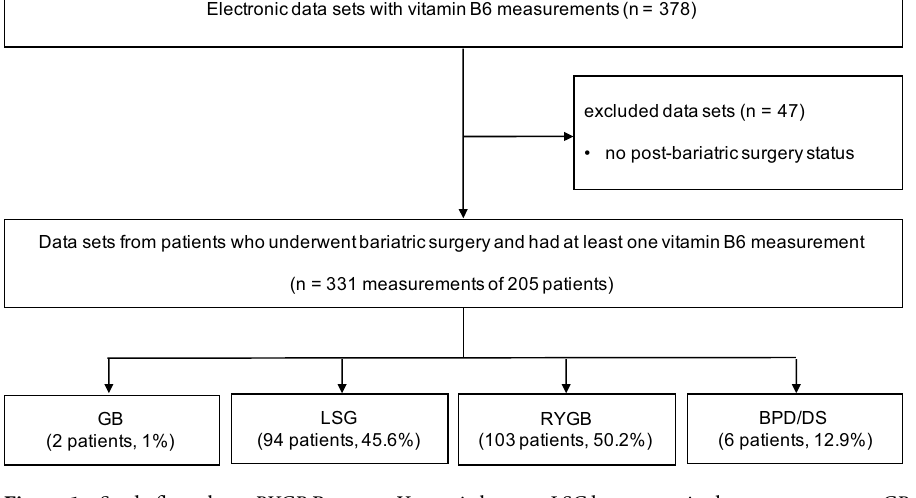
Figure 1. Study flow chart. RYGB Roux-en-Y gastric bypass, LSG laparoscopic sleeve gastrectomy, GB gastric banding, BPD biliopancreatic diversion, DS duodenal switch, n number of